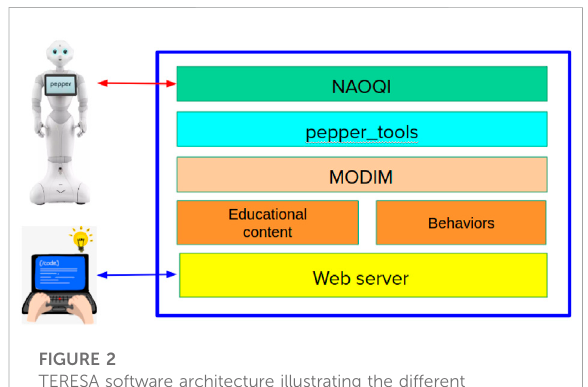
FIGURE 2 TERESA software architecture illustrating the different software layers used in the